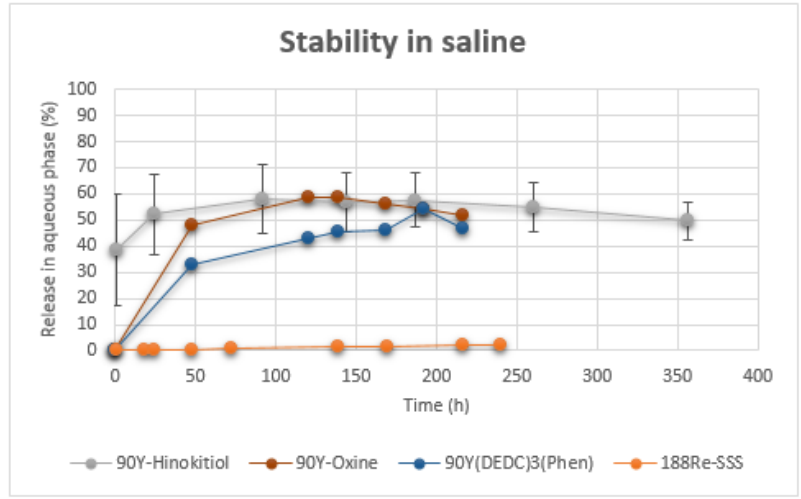
Figure 8. Release of radioactivity ( 90 Y, 188 Re) in aqueous phase over time.